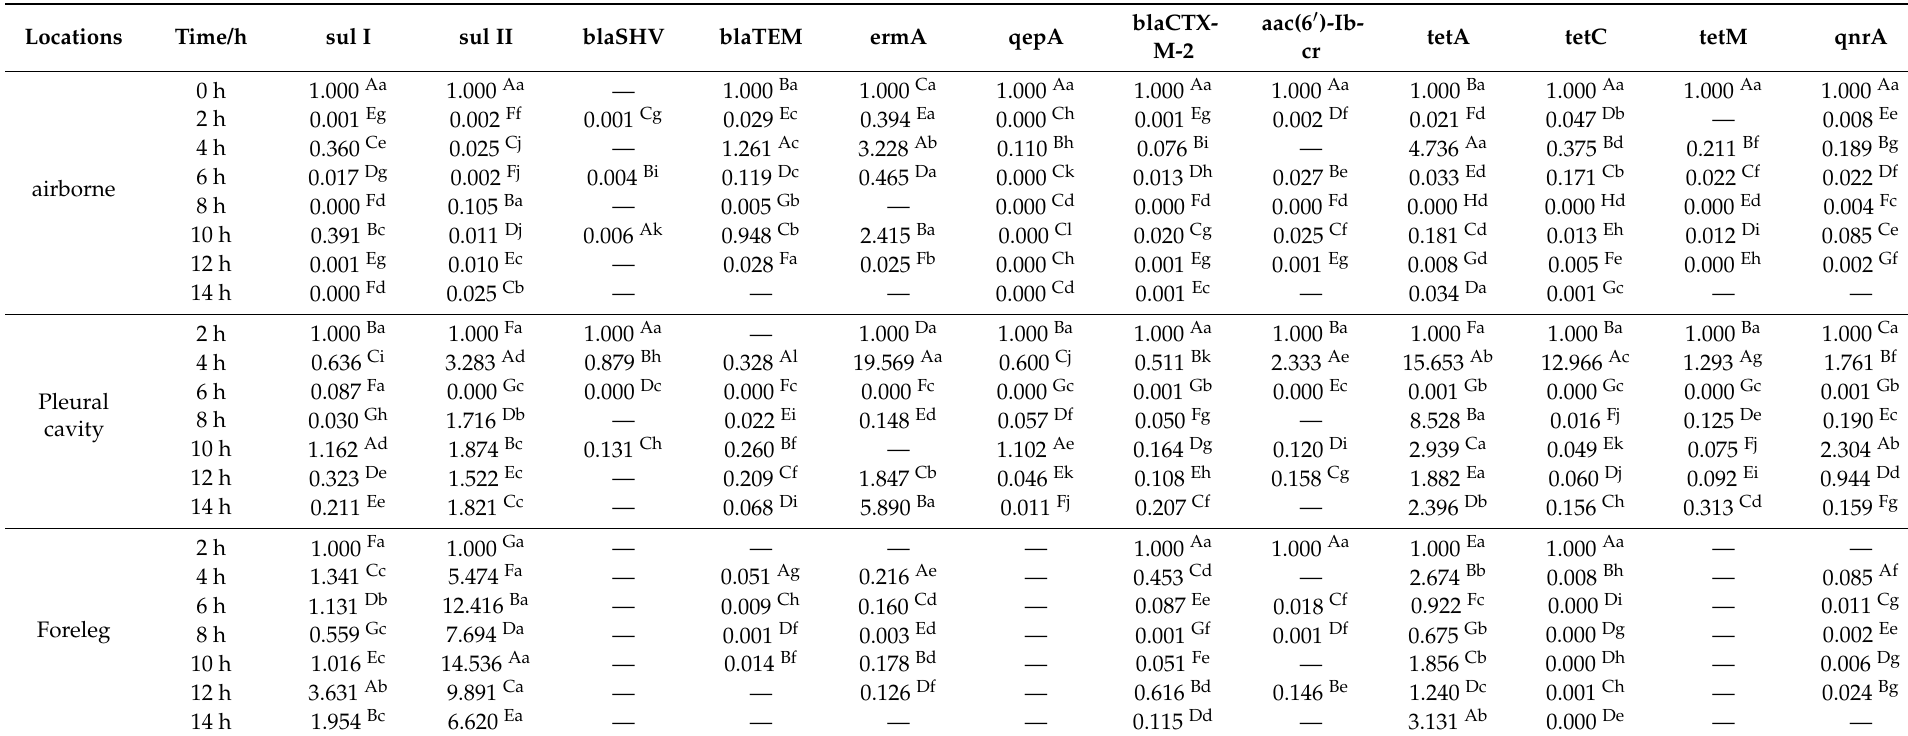
Table 5. Relative abundance of drug-resistant genes in microbiota samples from the air and the surface of pleural cavity and foreleg. Locations